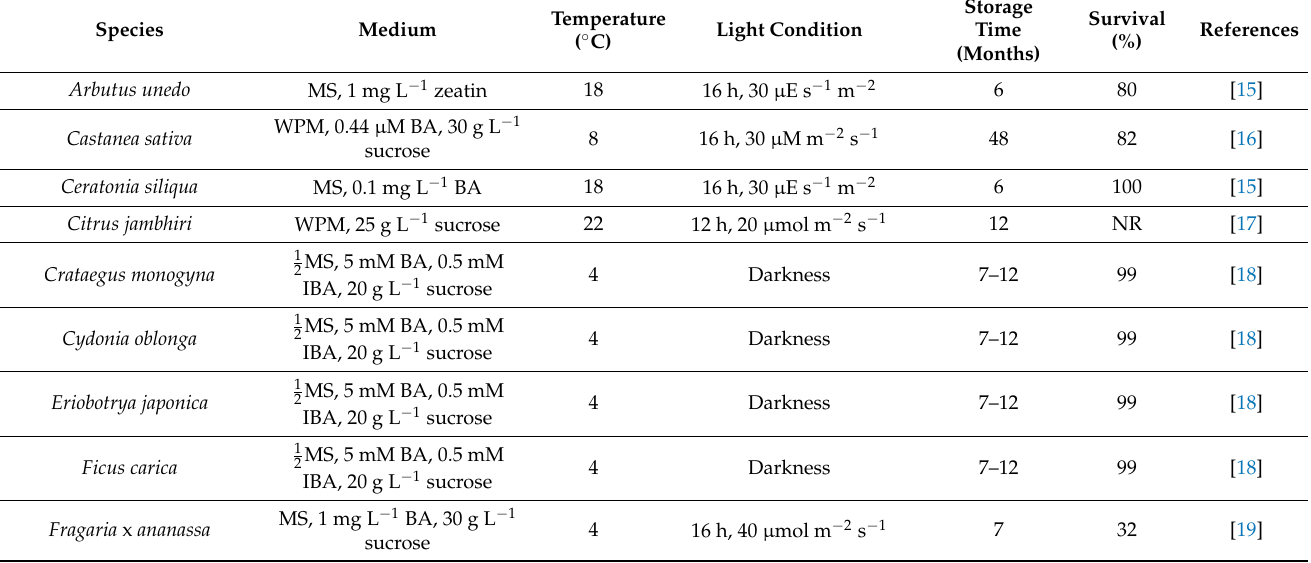
Table 1. Shoot conservation of temperate fruit crops in SGS from 2012 to present. Culture conditions and best results are reported for each species (terminology and values are the same as mentioned by the